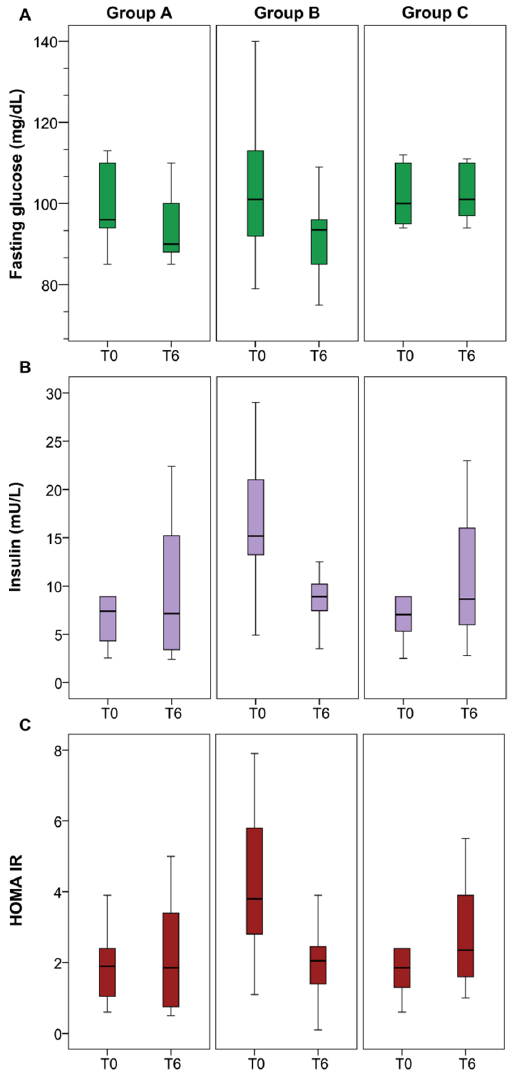
Figure 1. Comparison of fasting glucose ( A ); insulin ( B ) and HOMA-IR ( C ) at baseline (T0) and after six months (T6), among the three groups (Group A = diet; Group B = diet/BIL complex; Group C = control, without diet and antioxidant supplementation).